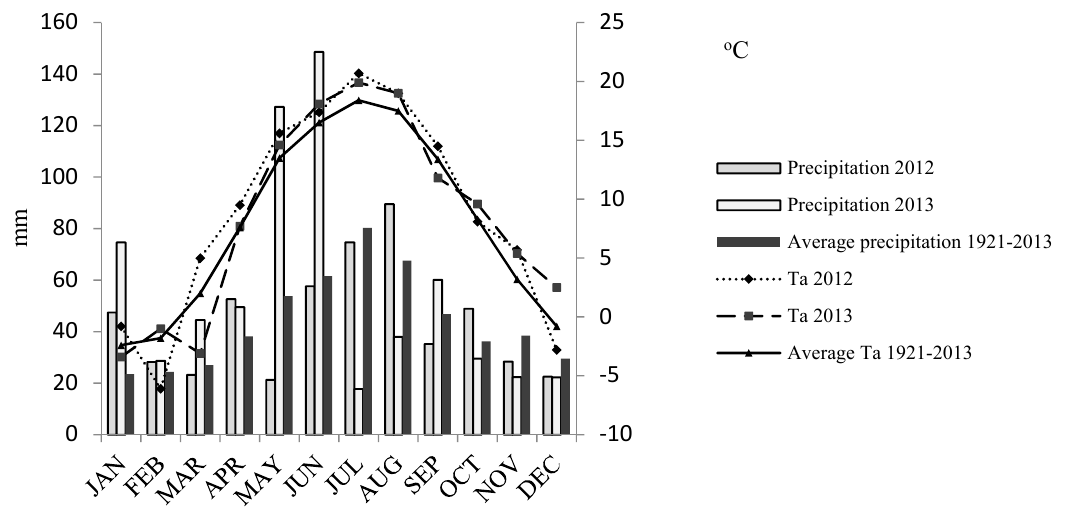
Figure 1. Monthly precipitation and average air temperature in 2012 and 2013.